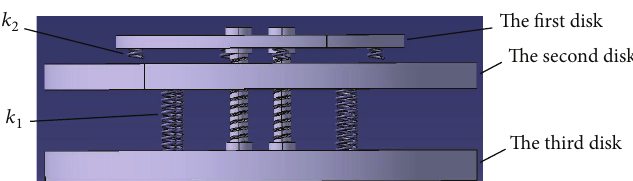
Figure 24: Experimental three-dimensional diagram of looseness